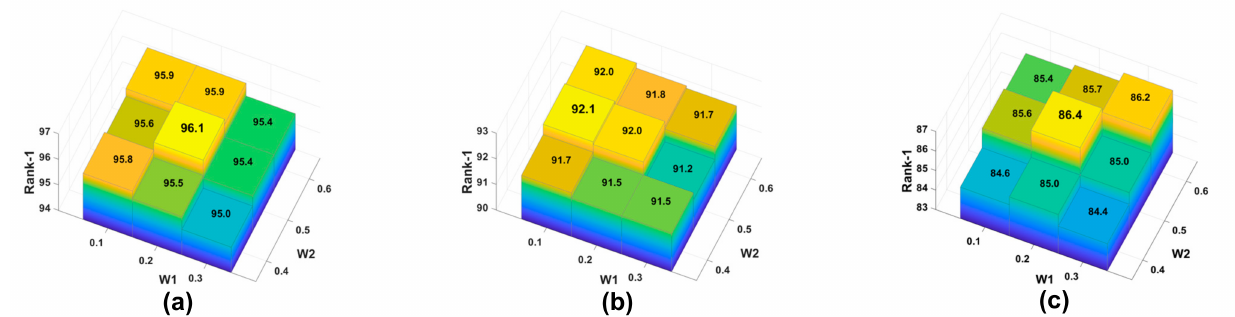
Figure 6. Loss function optimization for DBA-Net on three datasets. ( a ) The Market-1501 dataset. ( b ) The DukeMTMC-ReID dataset. ( c ) The Cuhk-03 dataset.